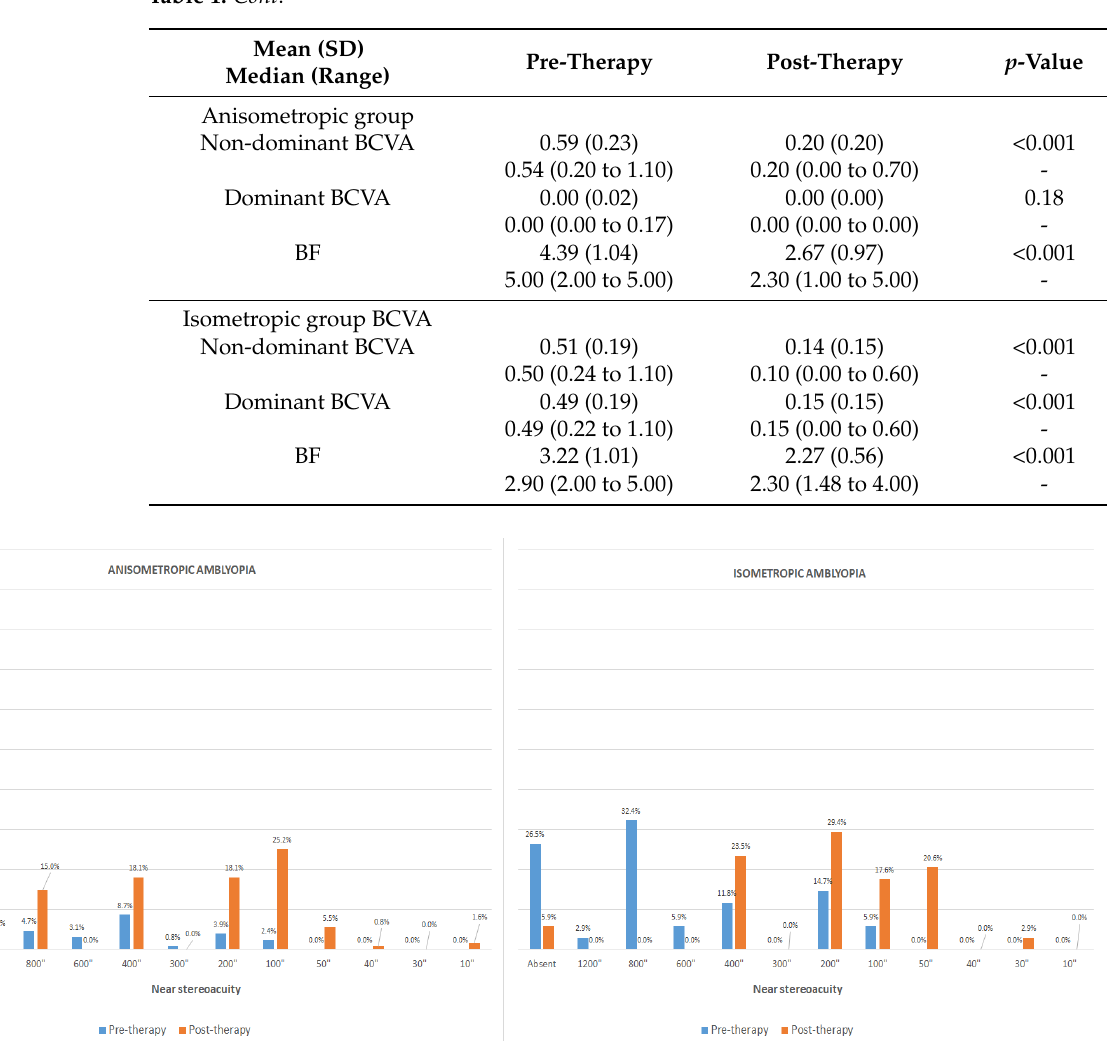
Figure 5. Distribution of the pre-and post-therapy measurements of near stereoacuity in the groups of anisometropic and isometropic